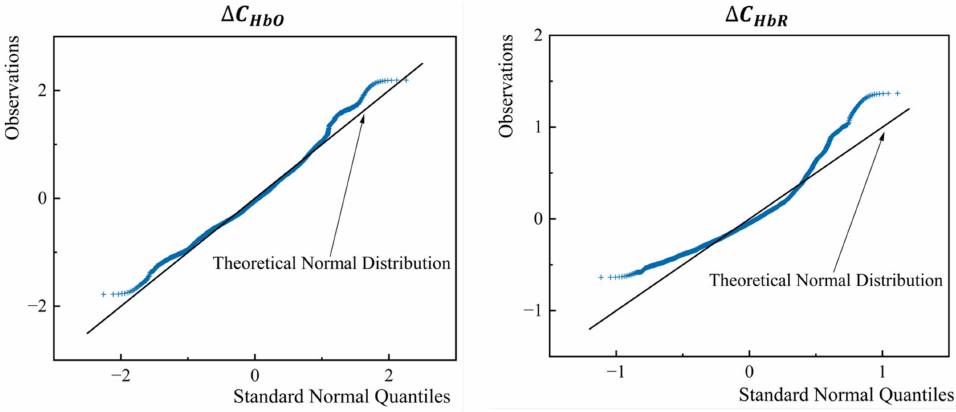
Figure 3. Normality test of signals (one